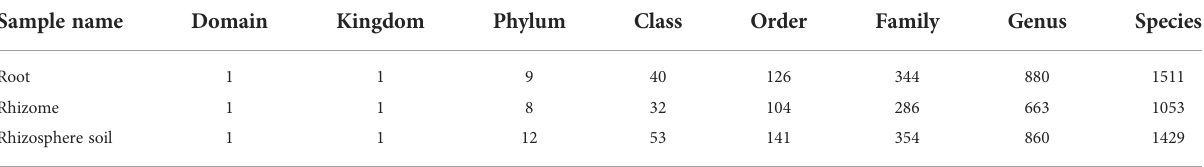
TABLE 2 OTU statistics of each classi fi cation level